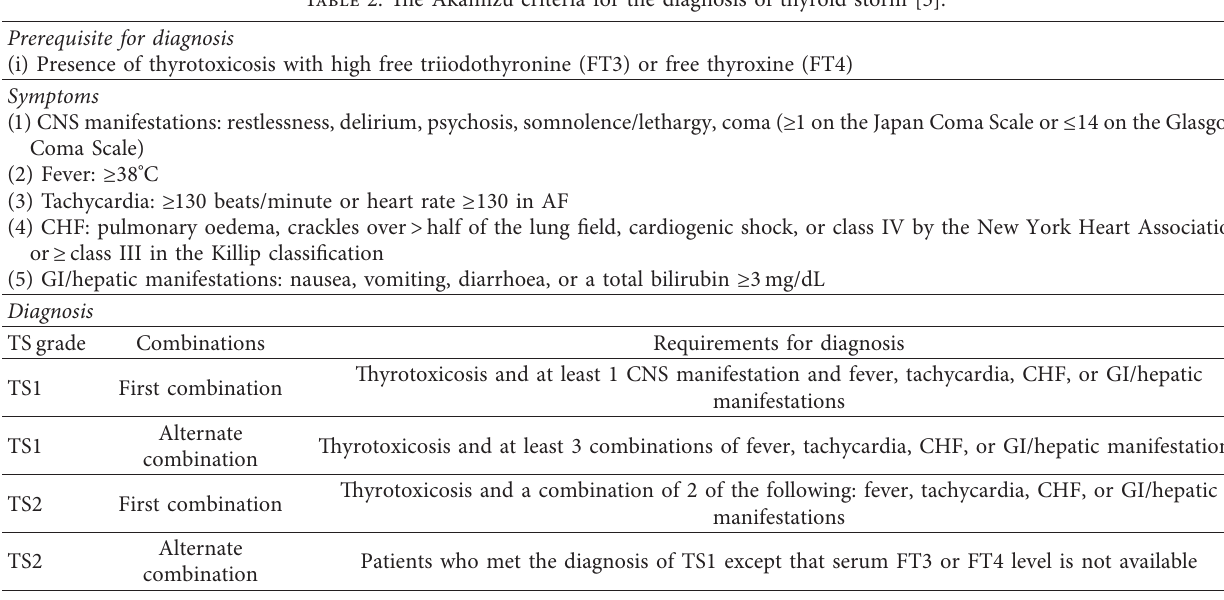
Table 2: The Akamizu criteria for the diagnosis of thyroid storm